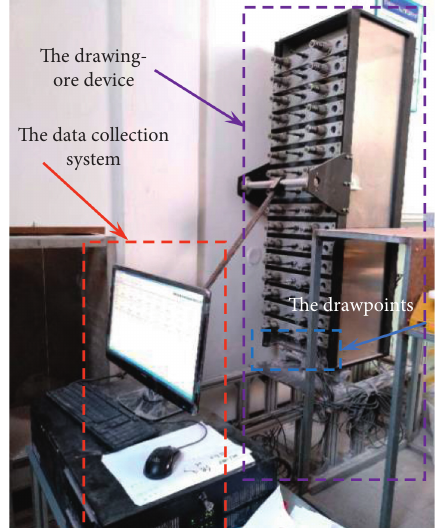
Figure 1: The schematic diagram of the physical model.